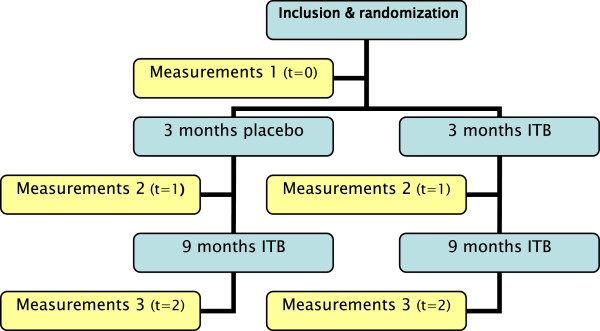
Flow chart subjects.